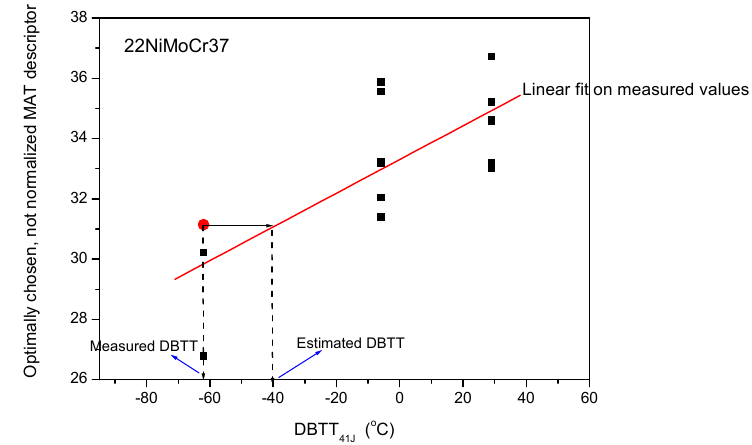
Figure 8. Optimally chosen, not normalized MAT descriptor of reference and of irradiated 22NiMoCr37 type reactor steel material as a function of transition temperature, DBTT. The procedure of how the estimated DBBT value was determined is shown on one of the samples (red circle).